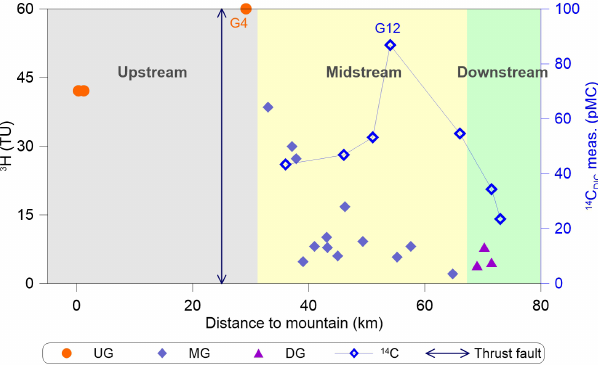
Figure 8. Distributions of 3 H and 14 C activities with distance to the mountain. The shaded regions indicate the upstream, midstream, and downstream of Manas